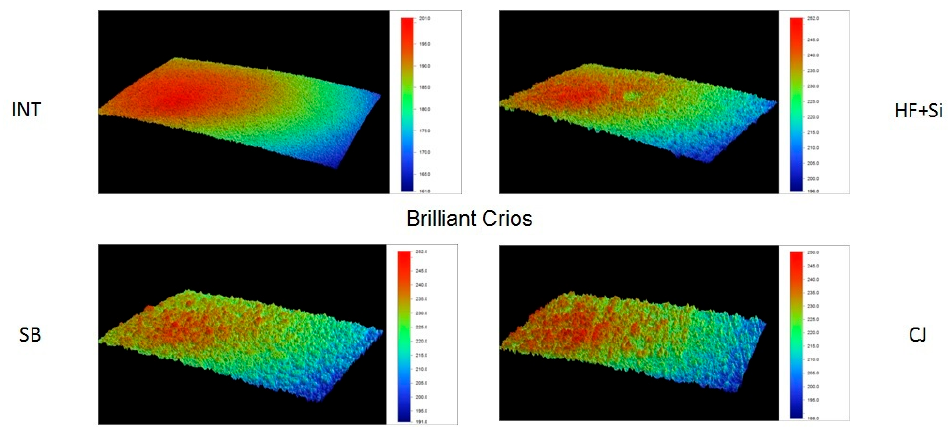
Figure 5. Representative 3D topographic surface maps of Brilliant Crios (×20 magnification).